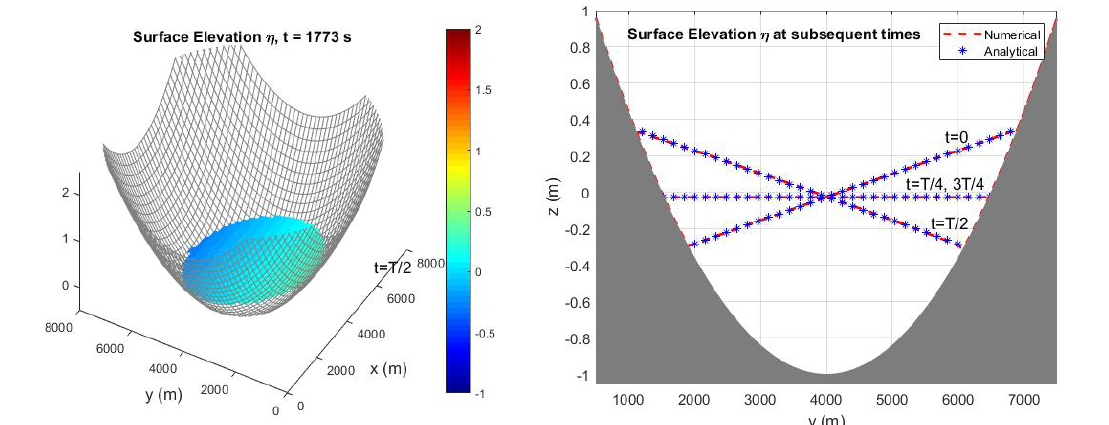
Figure 2. Centerline of planar surface profile from numerical as well as the analytical at subsequent times t = 0, T /4, T /2,3 T /4, T , with period T = 3546